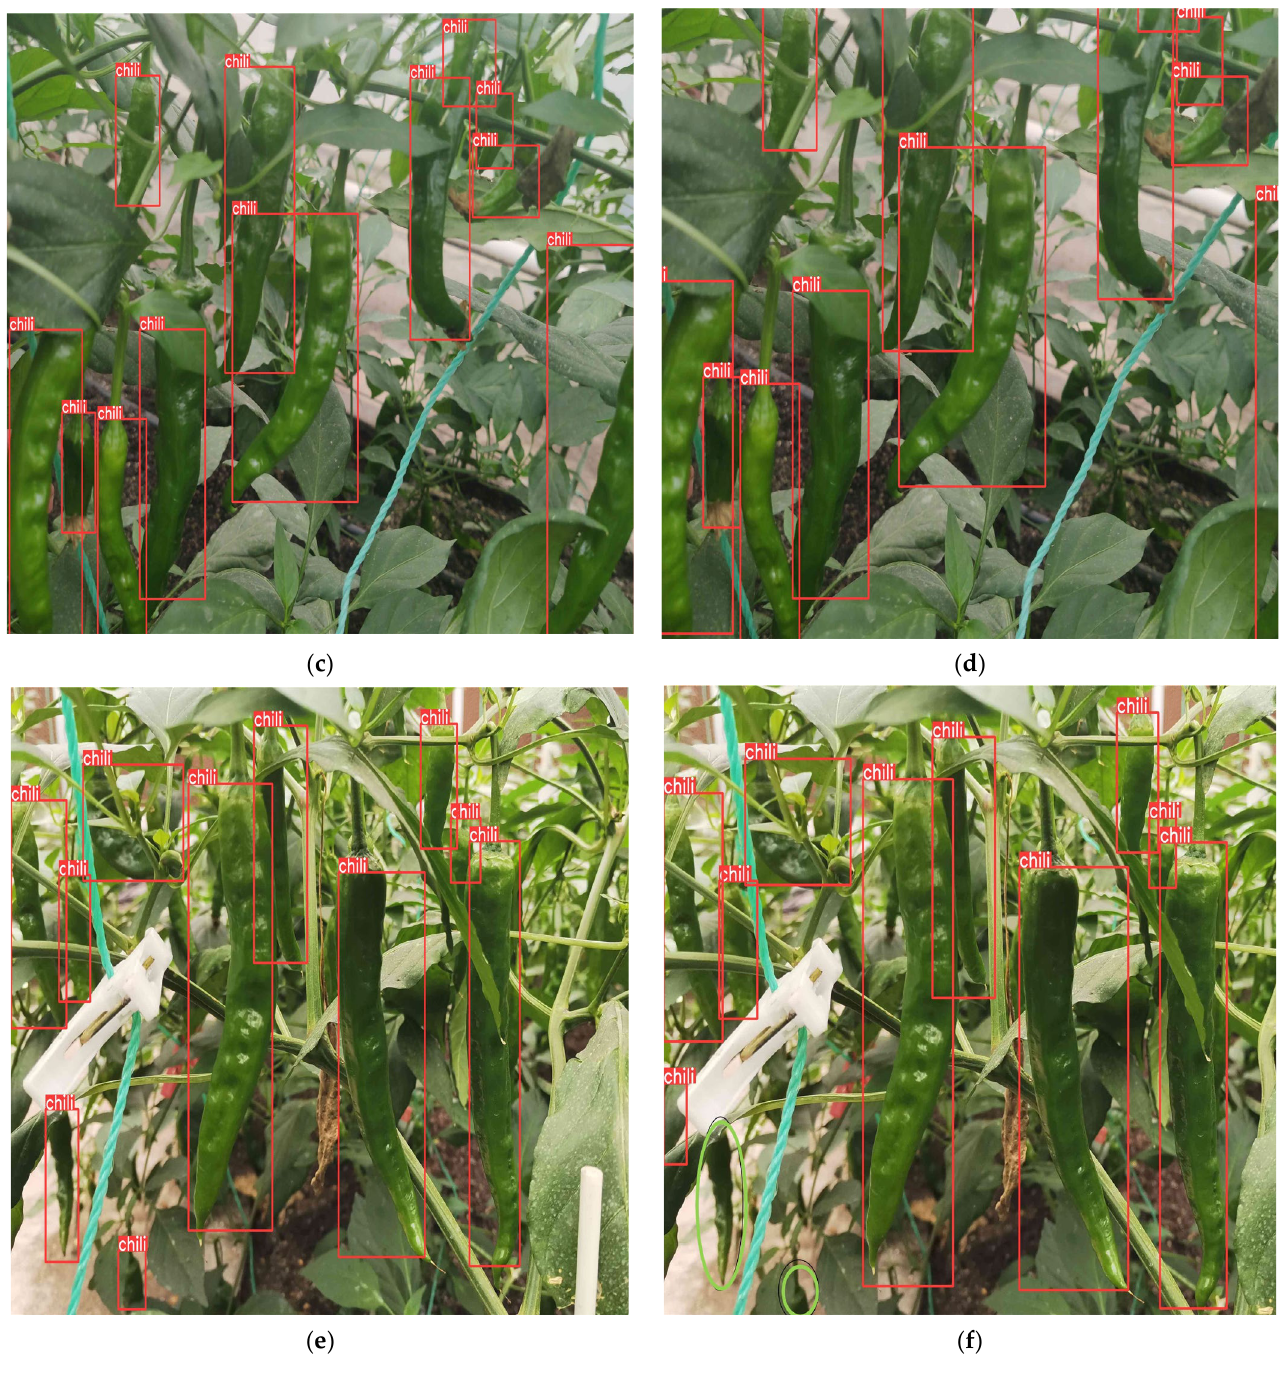
Figure 14. Comparison between original YOLOV5s and GNPD - YOLOv5s model. ( a ) chili detection of the original YOLOv5s model ; ( b ) GN - YOLOv5s was used for comparison of chili detection; ( c ) Detection results of the original YOLOv5s model in light occlusion environment; ( d ) Comparison of GNPD - YOLOv5s models in light occlusion environment; ( e ) Detection results of the original YOLOv5s model under severe occlusion; ( f ) Comparison of GNPD - YOLOv5s model in severely occluded environment. (Green marks represent missed chilies.) .